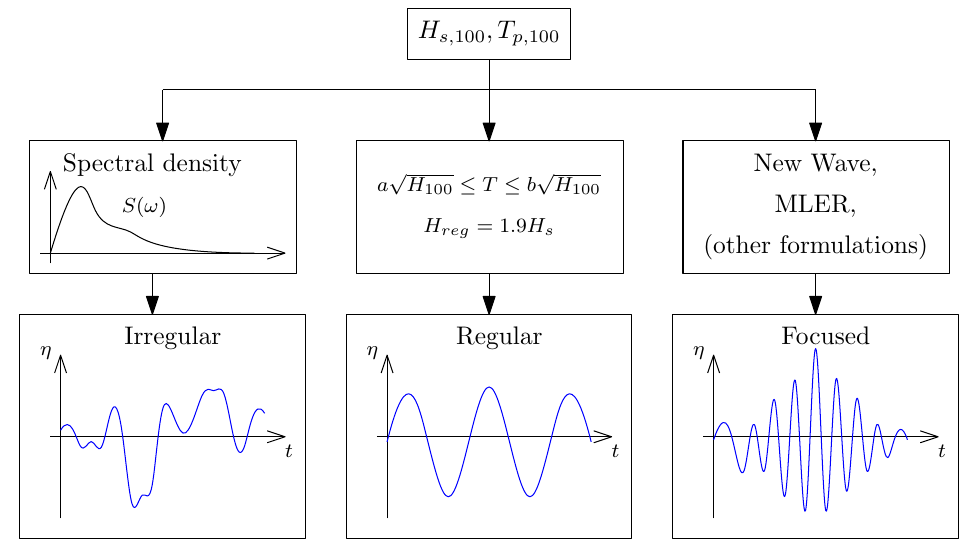
Figure 4. Design-wave